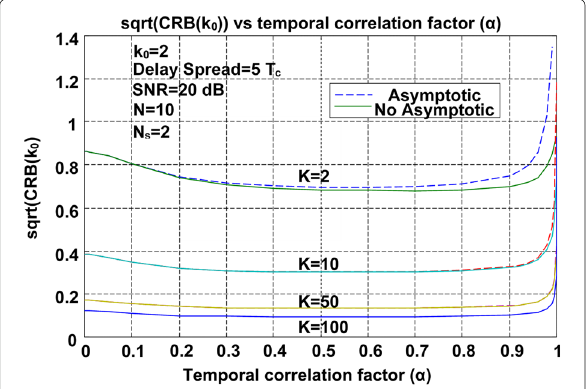
Fig. 2 CRB of the first arriving path k 0 in terms of the temporal correlation coefficient α . Results for the square root of the CRB are displayed for different sizes K , of the record containing the channel vector estimates, for both the asymptotic (dashed) and no asymptotic (solid) expressions. SNR has been set to 20 dB, delay spread to 5 T c , and for two sensors in the antenna